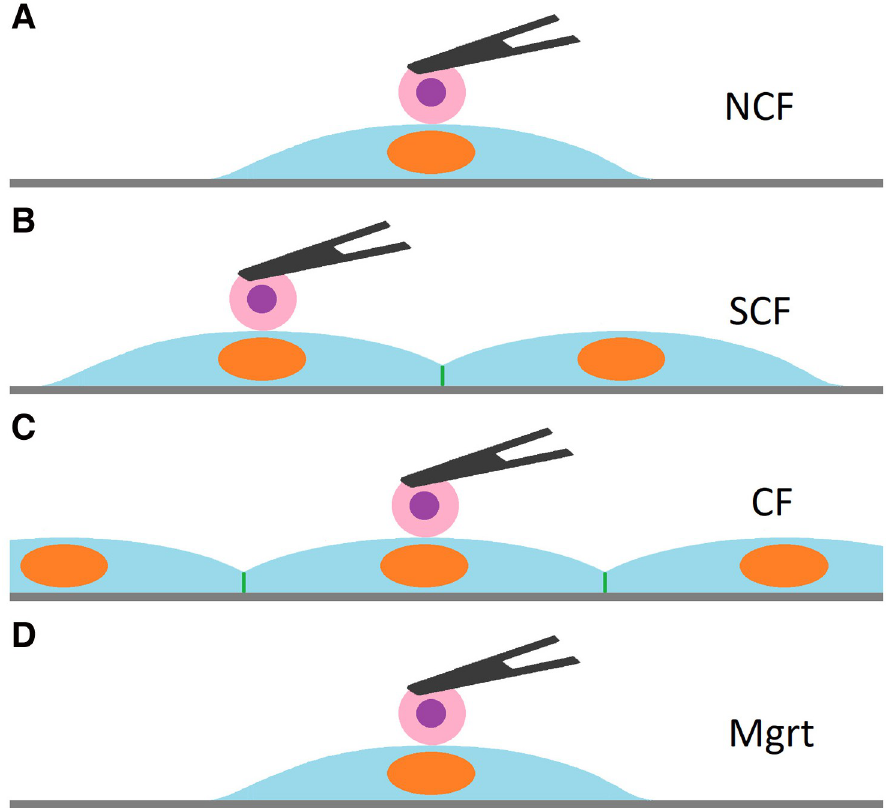
Fig 3. Detection of cancer cell adhesion to ECs at four different growth states. To compare adhesions at different EC growth states, a MB231 cell (Pink with purple) attached to the cantilever (black triangle) was brought into contact with non-confluent (NCF) EC (A), sub-confluent (SCF) EC (B), confluent (CF) EC (C) and migrating (Mgrt) EC (D) over the EC nucleus for three different cell contact times (0.5, 10 and 60 sec).